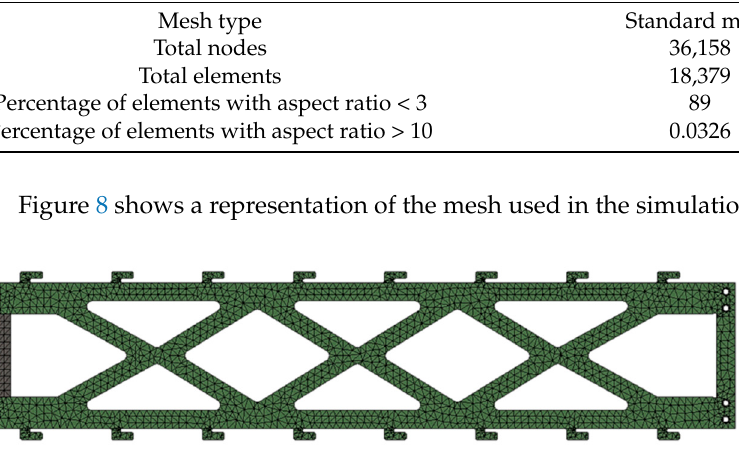
Figure 8. Representation of the mesh used in the simulation.